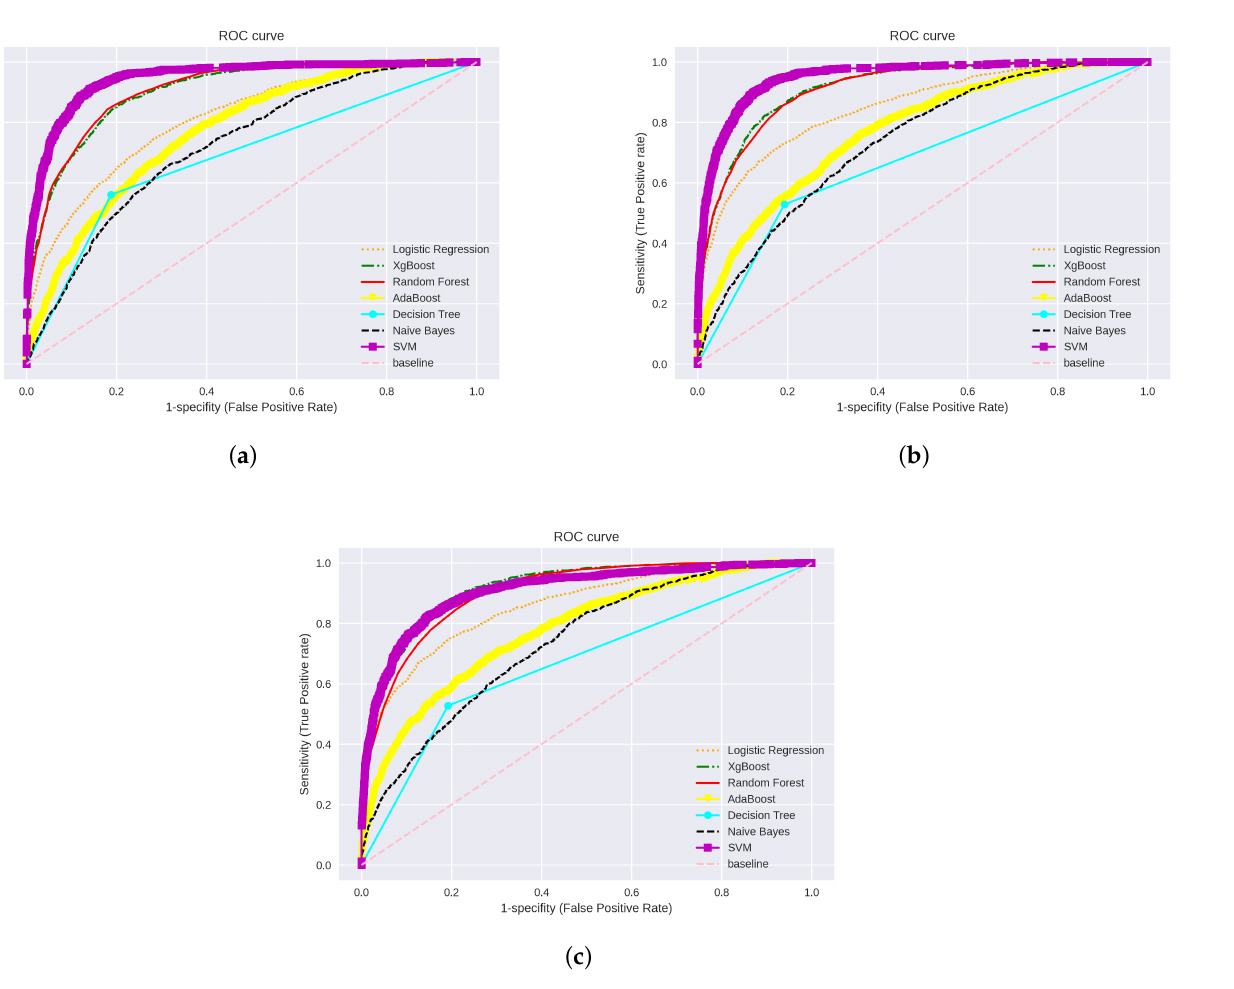
Figure 6. Visualisation of the ROC curves of traditional classifiers using ( a ) TF-IDF, ( b ) Glove, and ( c ) FastText word embedding